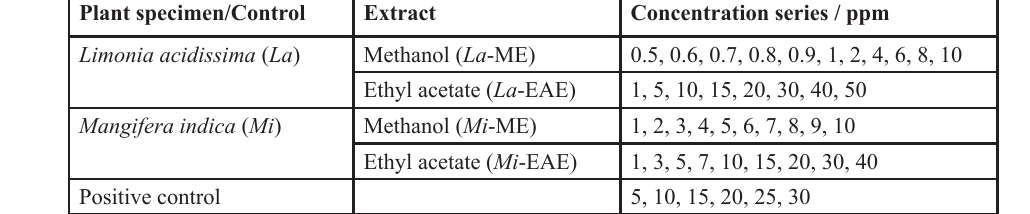
Table 1: Concentration series prepared for each extract and the positive control. Plant specimen/Control